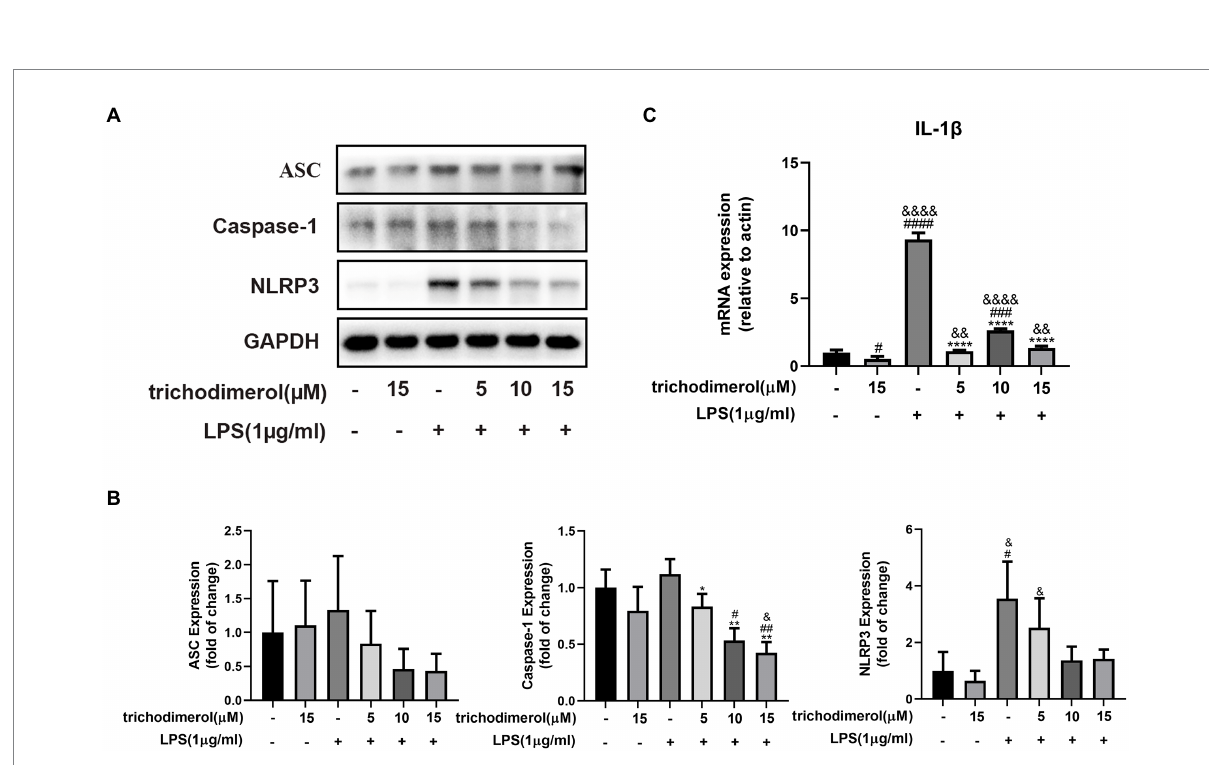
FIGURE 5 The effect of trichodimerol on the NLRP3 pathway. (A) RAW264.7 macrophages were treated with different concentrations of trichodimerol (5, 10, and 15 μ M) for 2 h, followed by LPS (1 μ g/ml) for 24 h. The protein expression of ASC, Caspase-1, and NLRP3 was detected by Western blotting; GAPDH was used as an internal reference. (B) Quantitative statistical results of the protein expression of ASC, Caspase-1, and NLRP3. (C) mRNA expression levels of IL-1 β . All data are expressed as the mean ± SD. # p < 0.05, ## p < 0.01, ### p < 0.001, #### p < 0.0001, compared with the DMSO group. & p < 0.05, && p < 0.01, and &&&& p < 0.0001, compared with the trichodimerol 15 μ M group. * p < 0.05, ** p < 0.01, and **** p < 0.0001, compared with the LPS